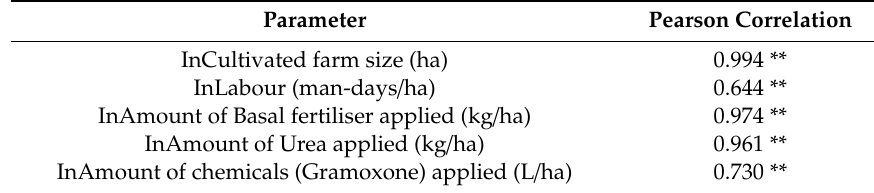
Table 4. Correlation Pearson (point biserial) analysis results between sugarcane production (yield—t / ha) and the independent variables ( n =